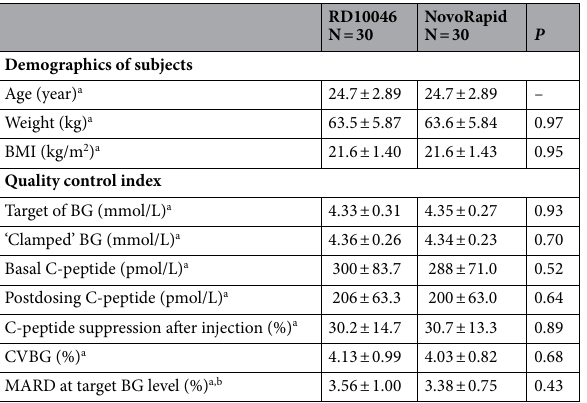
Table 1. Demographics of subjects and index to estimate the quality of euglycemic clamps. BMI body mass index, CVBG coefficient of variation of blood glucose, BG blood glucose, MARD mean absolute relative difference. a Mean ± SD. b MARD at the target BG level (%): 100 ×|(clamped BG − target BG)/target